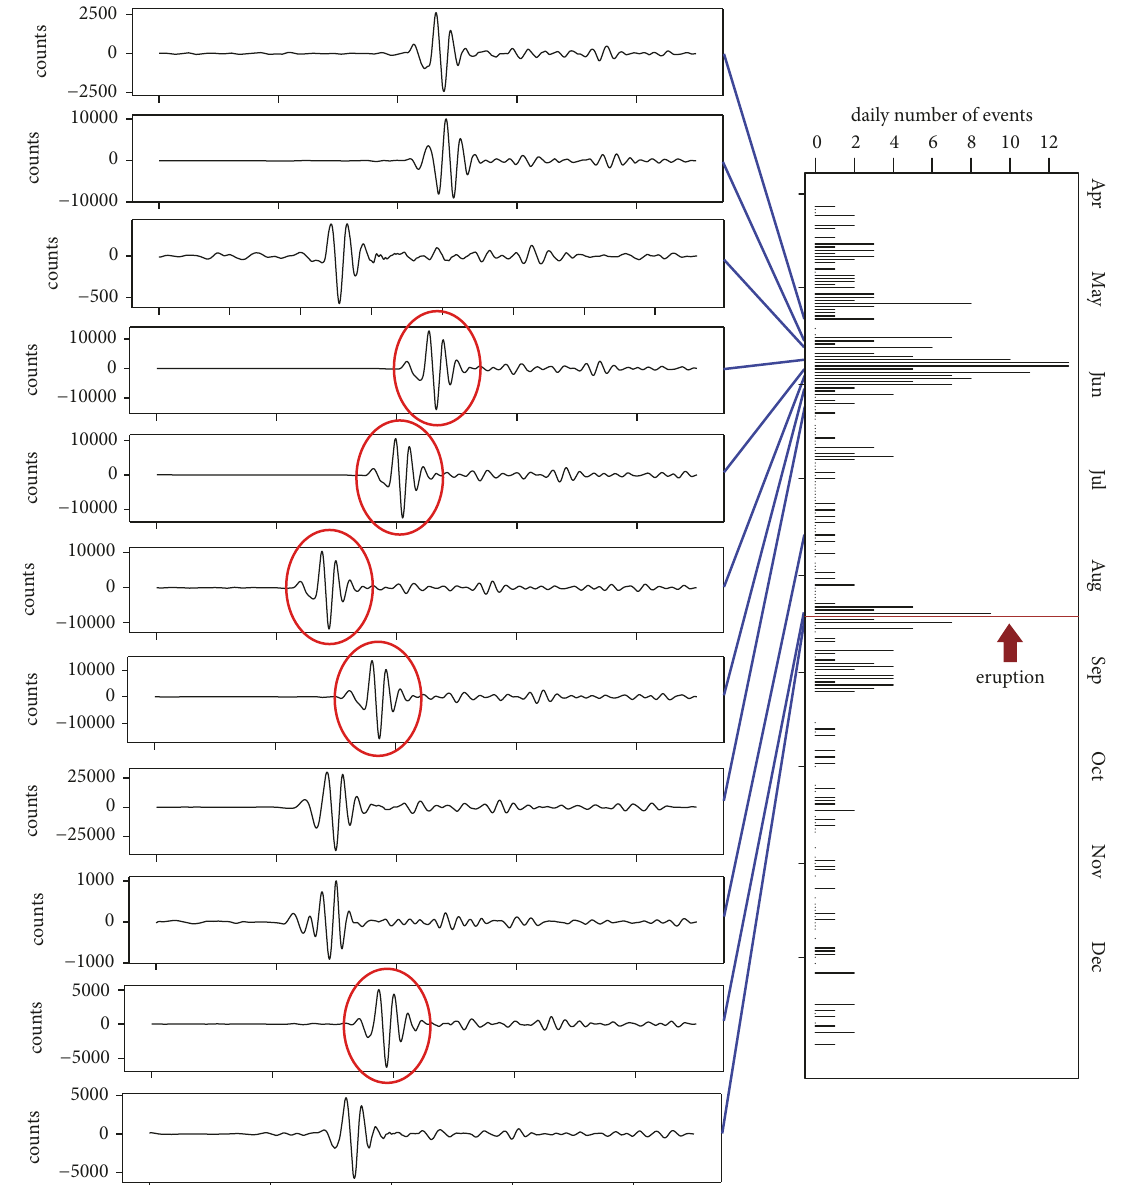
Figure 5: Temporaldistribution of selectedevents(filteredfrom 0.3to 1 Hz) in ClusterA. Thecircledeventsshow eventswith almost identical shape, which may indicate the same